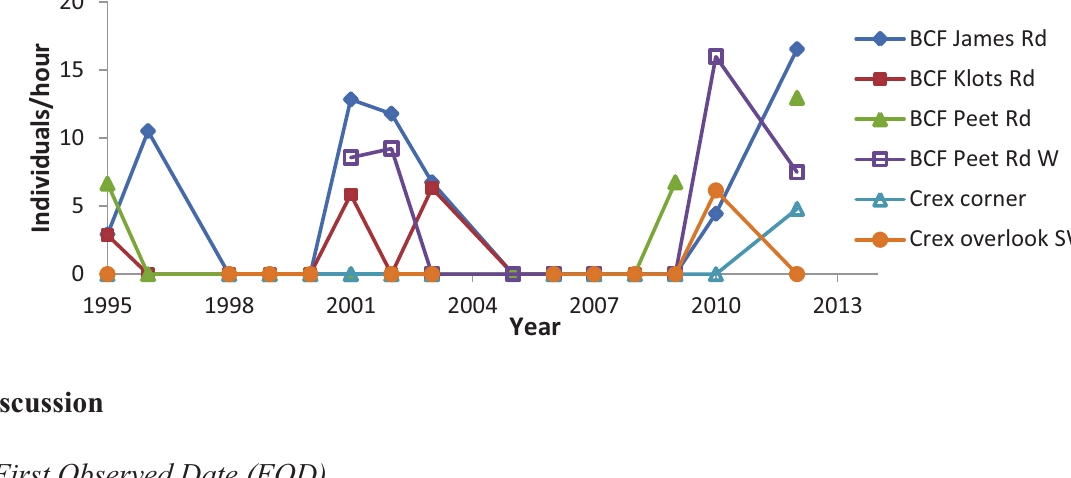
Figure 9. C. henrici abundance in northwestern Wisconsin sites (Figure 1) in Burnett County Forest (BCF) and Crex Meadows. Spearman rank correlation of trend (abundance versus year): r = +0.12196, N = 76 abundance indices from six sites surveyed nine to fifteen times during 1995 –